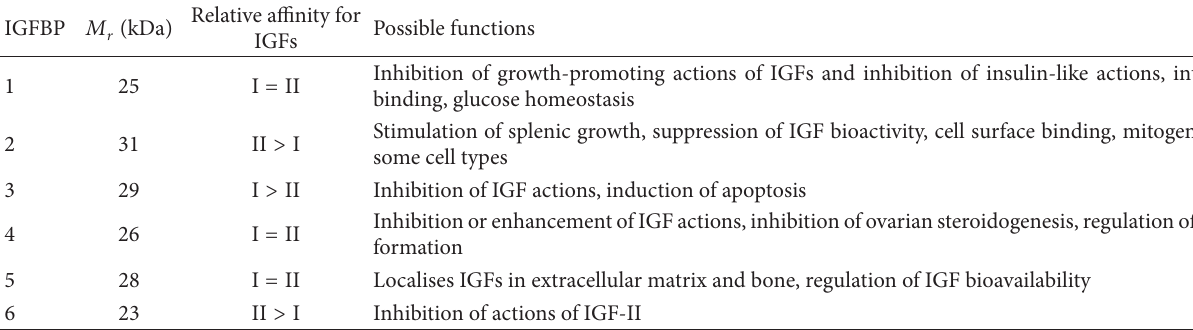
T 1: e insulin-like growth factor binding proteins (IGFBPs).